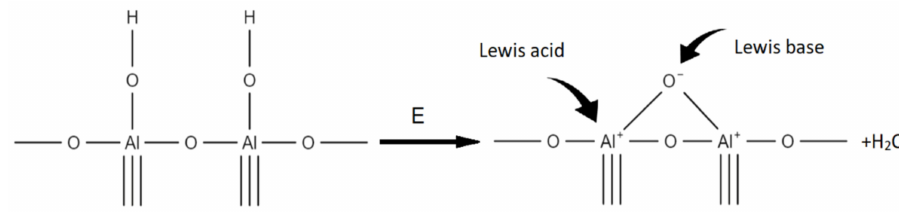
Figure 5. Oxygen bridge creation during plasma treatment according to Lewis principle.